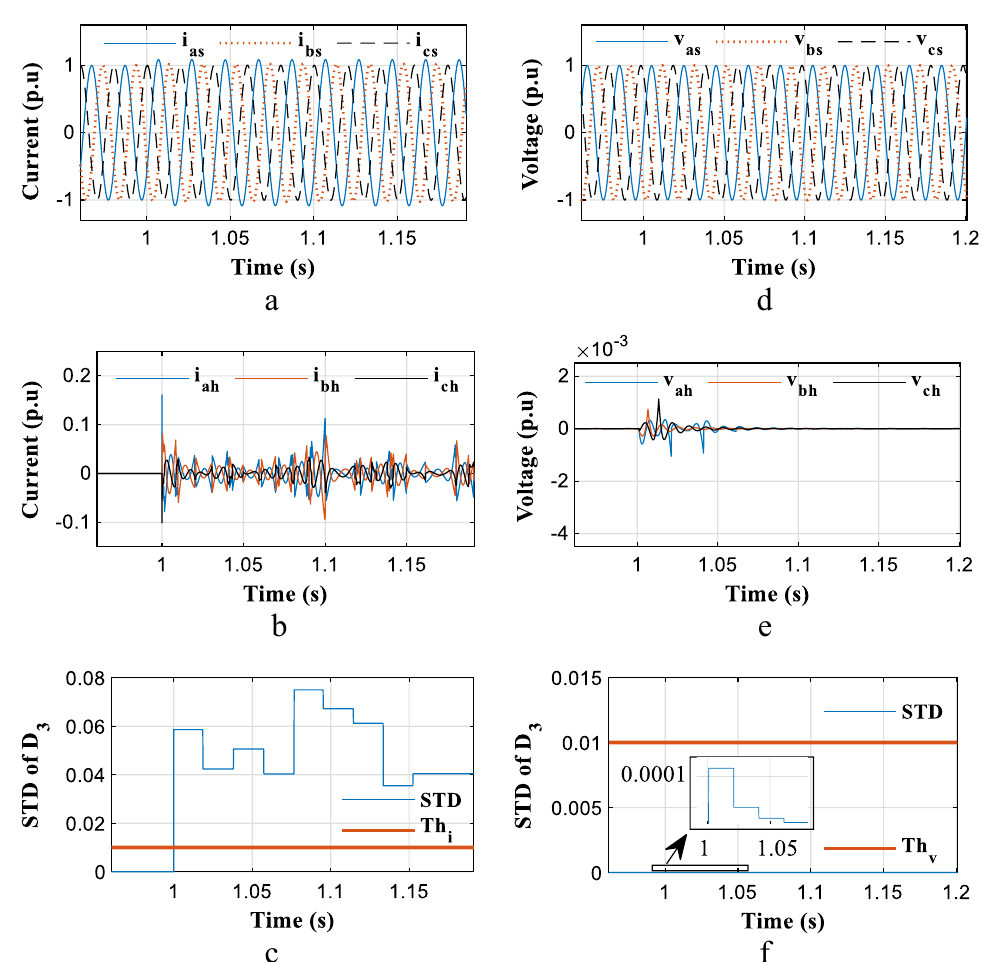
Fig. 8 Performance evaluation of proposed criteria using simulation results for an inter-turn fault ( µ = 0.05 ), a Three-phase stator current signals, b High-frequency components of three-phase stator current signals, c The current criterion, d Three-phase stator voltage signals, e High-frequency components of three-phase stator voltage signals, f The voltage